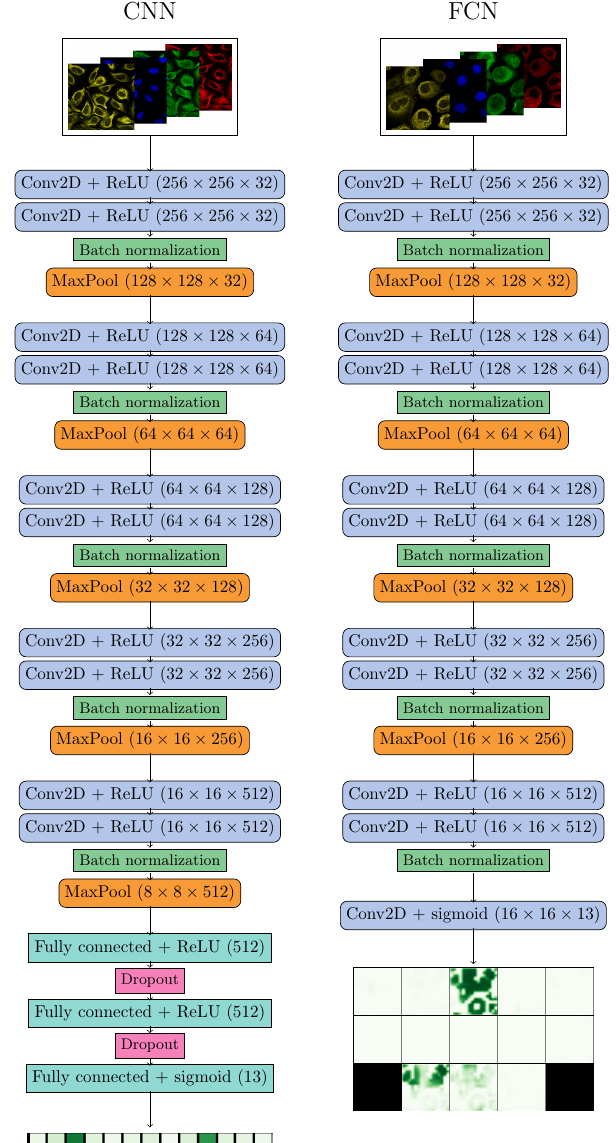
Figure 3. Convolutional neural networks (CNN) ( left ) and fully convolutional network (FCN) ( right ) architectures. An example output for a real input image is presented for FCN. The codes implementing the models used in this study are available at https://gitlab. com/BioimageInformaticsGroup/cytoclassifier/ (accessed on 10 February